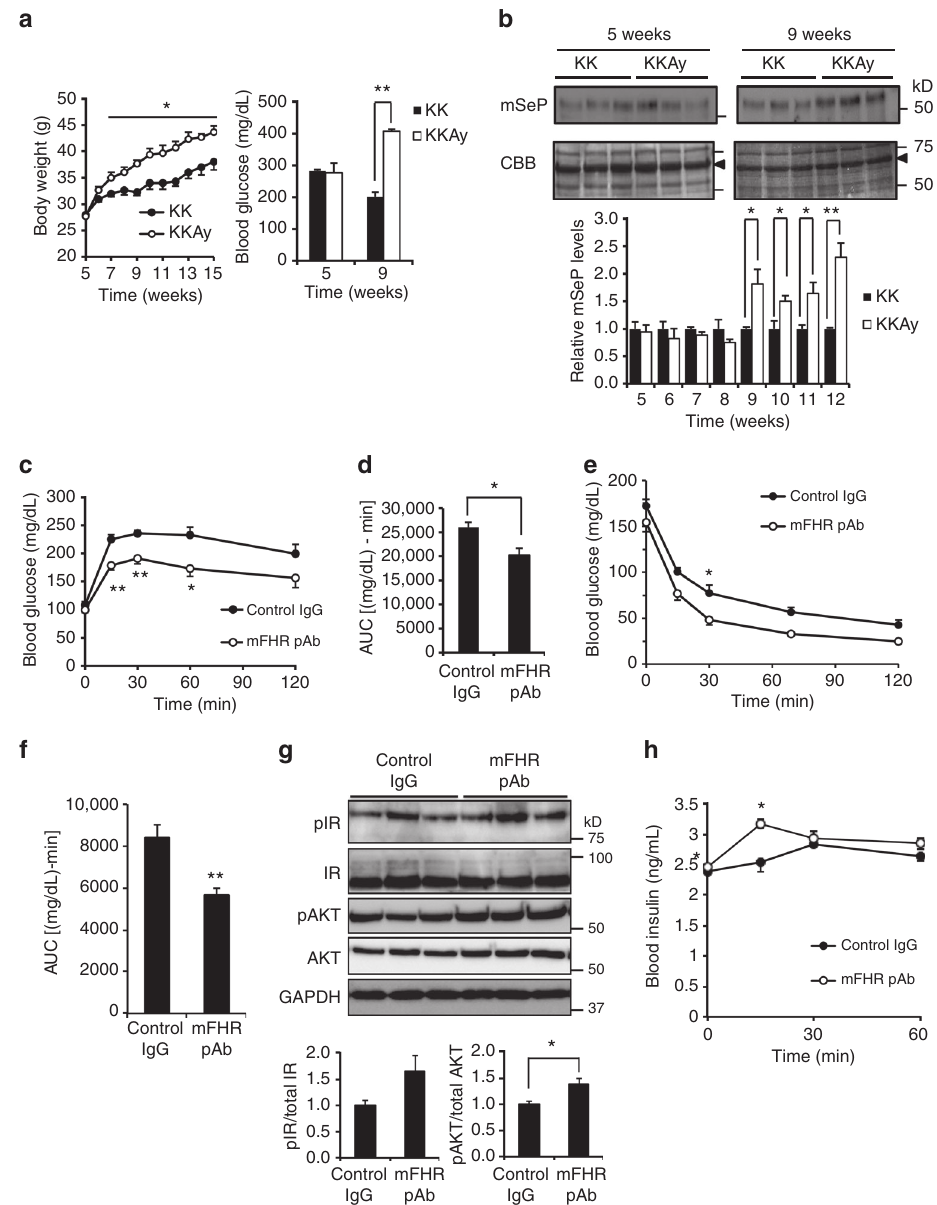
Fig. 7 Improvement of glucose metabolism in the KKAy mouse by SeP-neutralizing Ab. a , b Time-dependent change of body weight, blood glucose ( a ) and plasma mSeP level ( b ) concentration in KKAy mice ( n = 3, means ± s.e.m.). Closed circle, KK; open circle, KKAy. Graphs display the results of densitometric quanti fi cation, normalized to major protein (albumin, indicated by black arrowhead) stained with CBB ( b , n = 3, means ± s.e.m.). ** P < 0.01, * P < 0.05, Tukey-ANOVA ( a , b ). c , d Improvement of glucose tolerance in KKAy mice administered mSeP-neutralizing Ab. Mouse SeP neutralizing mFHR pAb or control rabbit IgG (25 mg/kg intraperitoneally) was administered 24 h before a glucose tolerance test following the scheme shown in Supplementary Fig. 8a. Glucose (0.3 g/kg body weight) was administered intraperitoneally, and blood glucose was determined at the indicated times ( c , n = 5, means ± s.e.m.). * P < 0.05, ** P < 0.01, Tukey-ANOVA. Area under the curve for blood glucose levels is shown in d ( n = 5, means ± s.e.m.). * P <